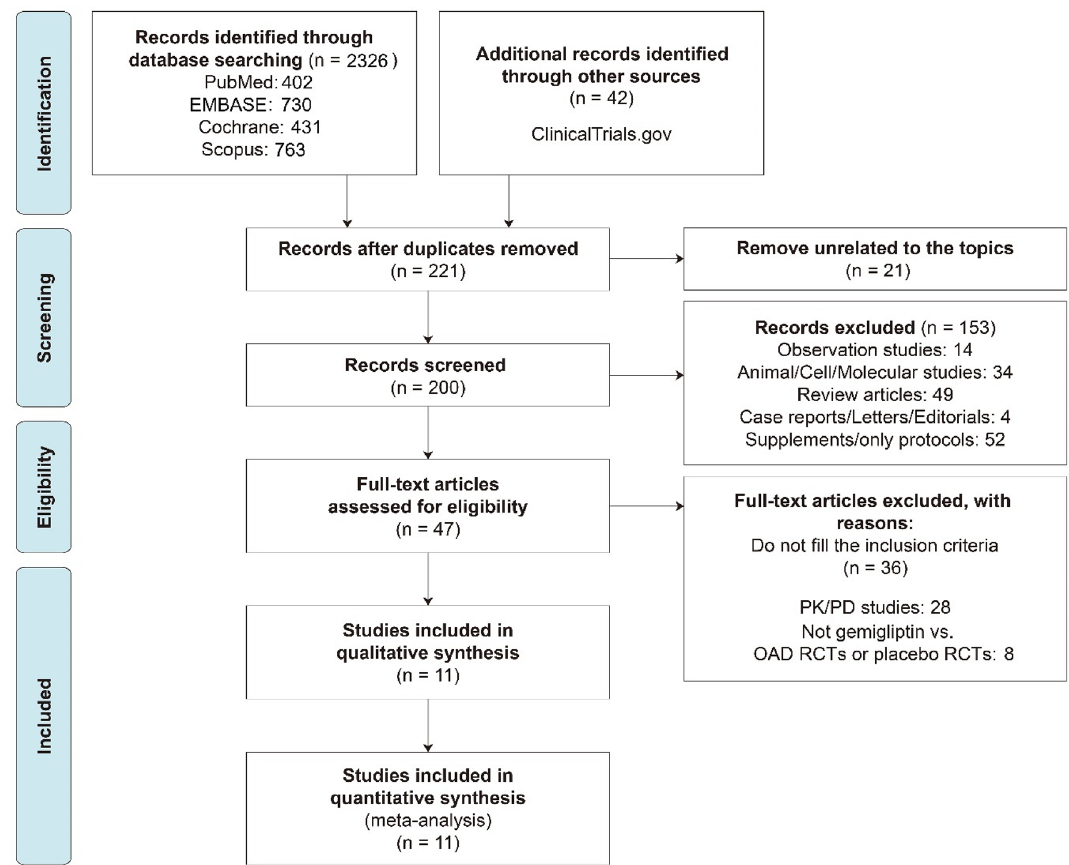
Figure 2. Flow chart of the studies selected and included in the